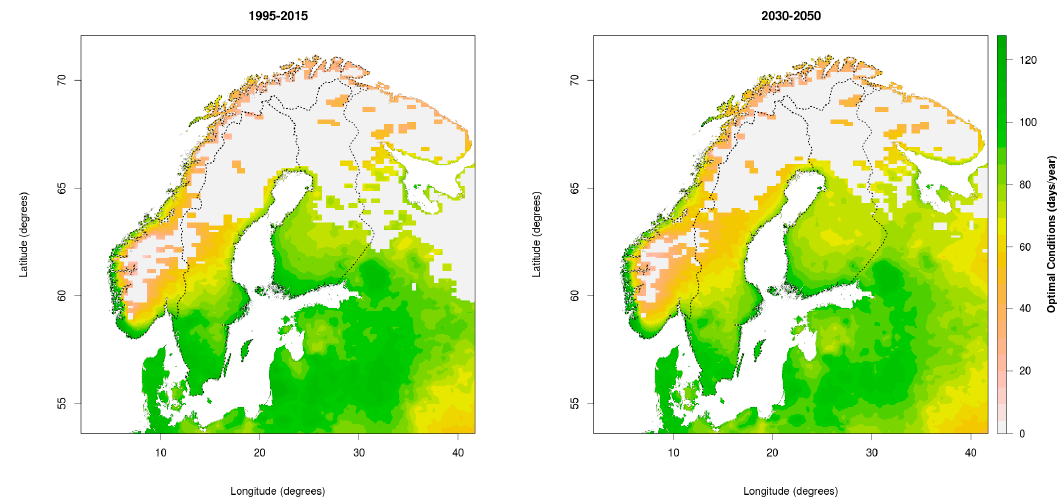
Figure 2. Mean number of days per year from March to November with optimal climatic conditions for tick development for past/present (1995–2015) and future (2030–2050).